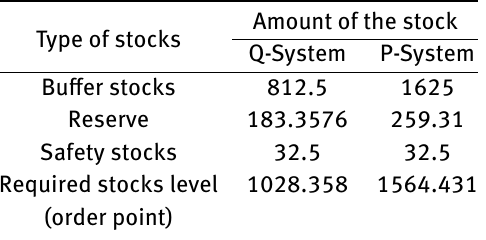
Table 2: Summary of data of types of stocks and the required stocks level.